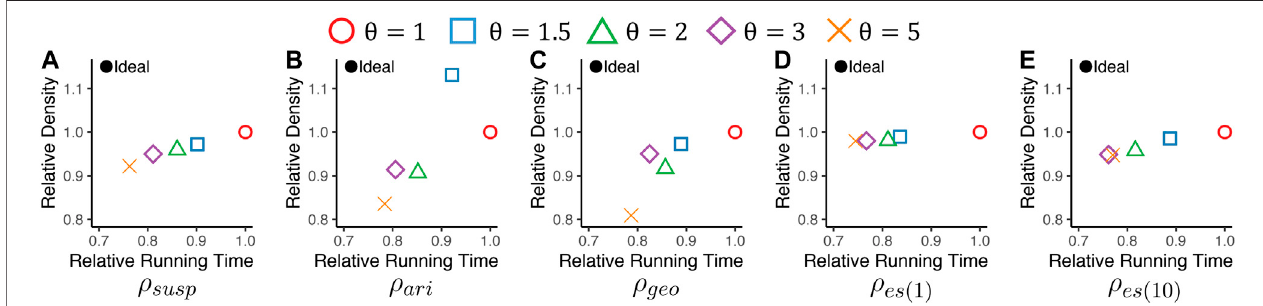
FIGURE7| Themass-thresholdparameter θ givesatrade-offbetweenthespeedandaccuracyof D-CUBE indense-subtensordetection.Wereporttherunningtime and the density of detected subtensors, averaged over all considered real-world datasets. As θ increases, D-CUBE tends to be faster, detecting sparser subtensors.